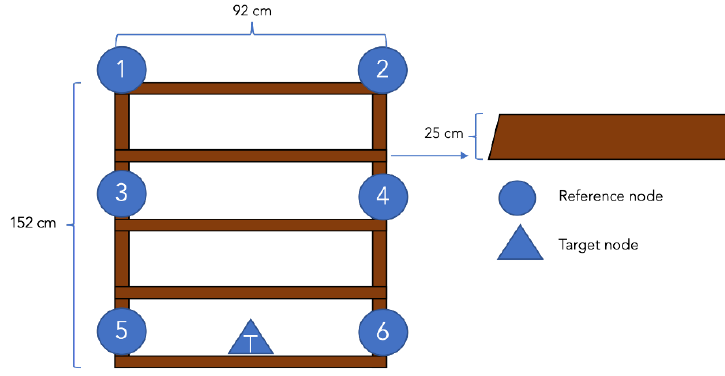
Figure 10. The illustration of a 3D environment in a